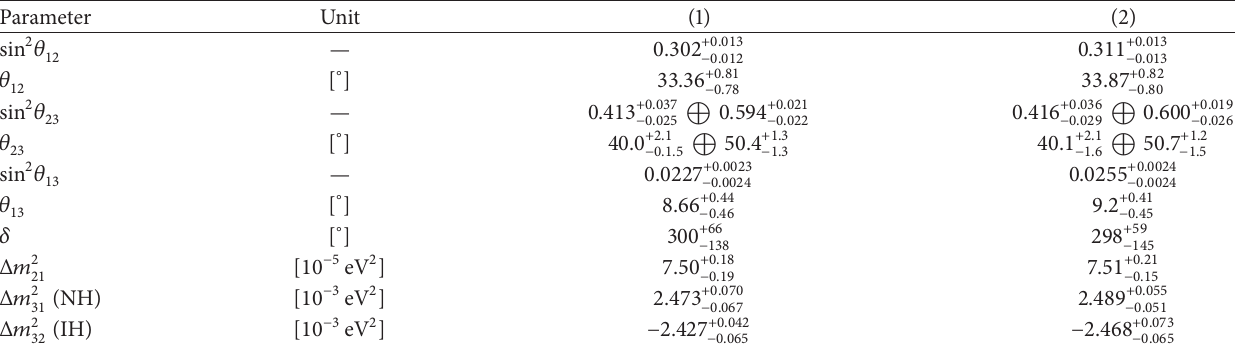
Table 8: Neutrino oscillation parameters from a global fit from [33]. Details in